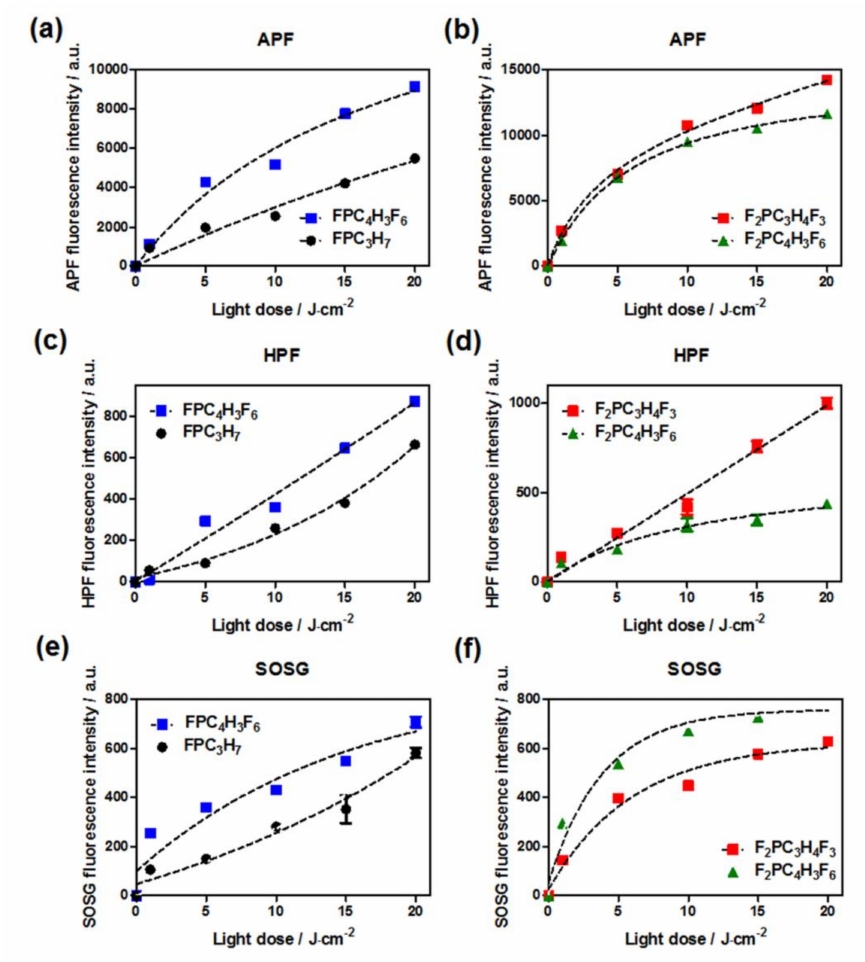
Figure 2. Detection of photogenerated reactive oxygen species using fluorescent probes at a concentration of 15 µ M: APF ( a , b ), HPF ( c , d ), SOSG ( e , f ); during irradiation of photosensitizer solution (10 µ